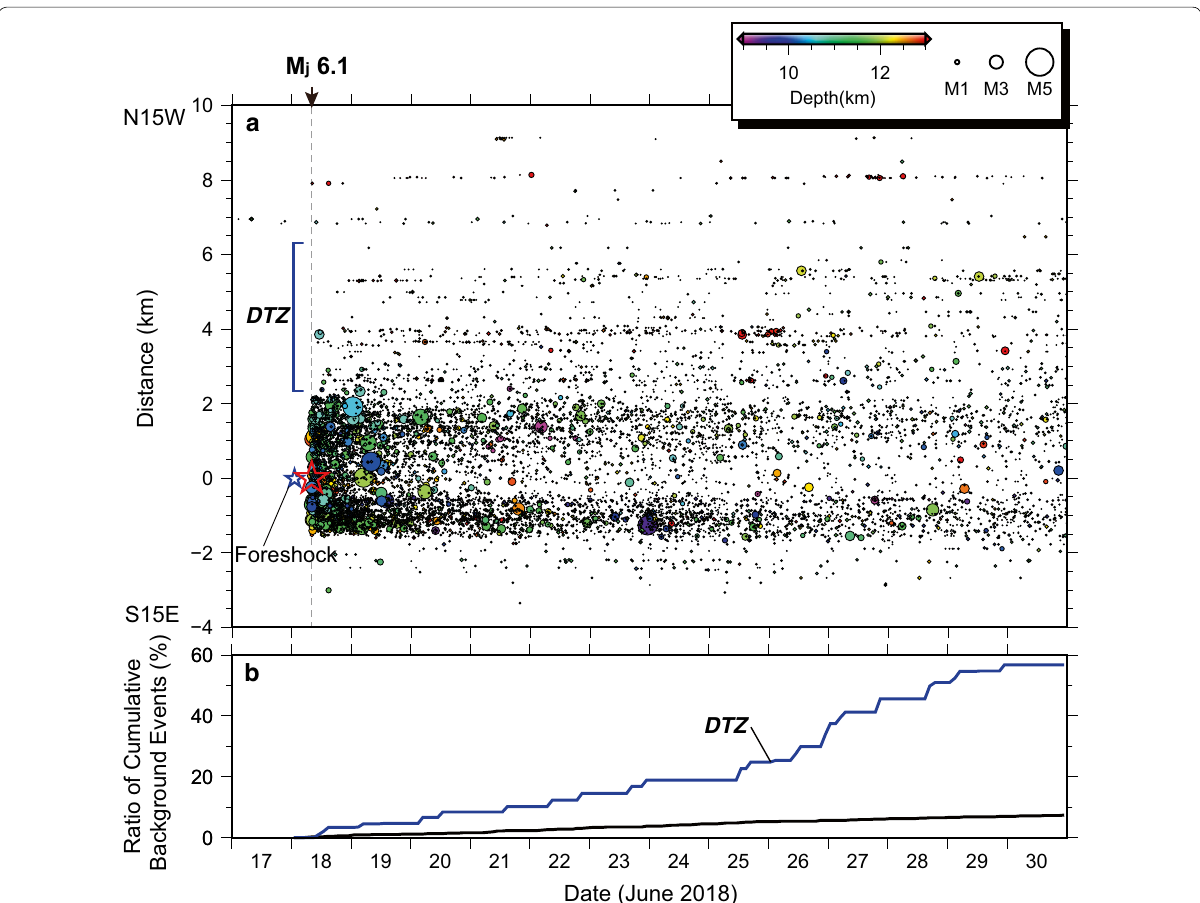
Fig. 3 Spatiotemporal evolution of seismicity revealed via the matched filter technique. a Space–time diagram of the detected events, which are shown as circles that are scaled to earthquake magnitude and colored to hypocentral depth. The blue and red stars denote the foreshock and mainshock events, respectively. DTZ indicates the zone with delayed triggered aftershocks. b Time series of the ratio of the cumulative number of background events to the total events in the two following areas. Blue curve: 2.3 km < Y < 6.3 km (DTZ). Black curve: the mainshock event is located at Y 0 km. Background events are earthquakes that were not triggered by other earthquakes. See the “Methods” = section for further